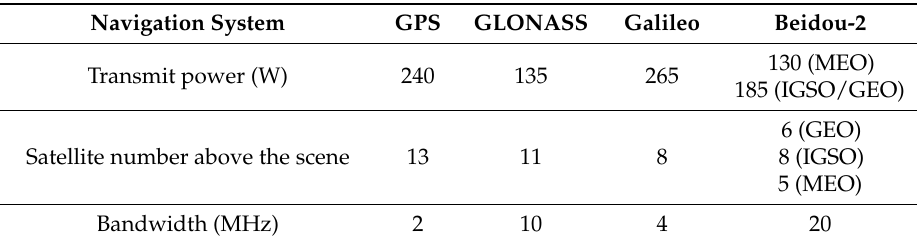
Table 6. Utilized system parameters of the main GNSS in the simulation.